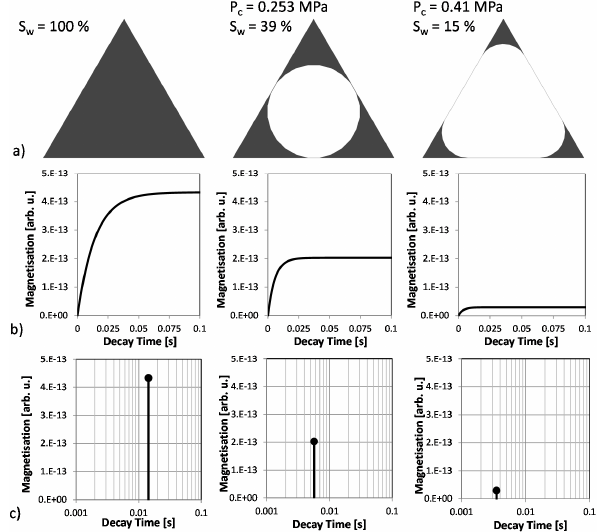
Figure 8. Water (black) and air (white) distributions within a tri- angular pore (A 0 = 4 . 33 × 10 − 13 m 2 , ρ s = 10µms − 1 ) at different capillary pressures for imbibition (a) with corresponding evolu- tion of the (longitudinal) magnetization (b) and NMR T 1 relaxation times (c) .